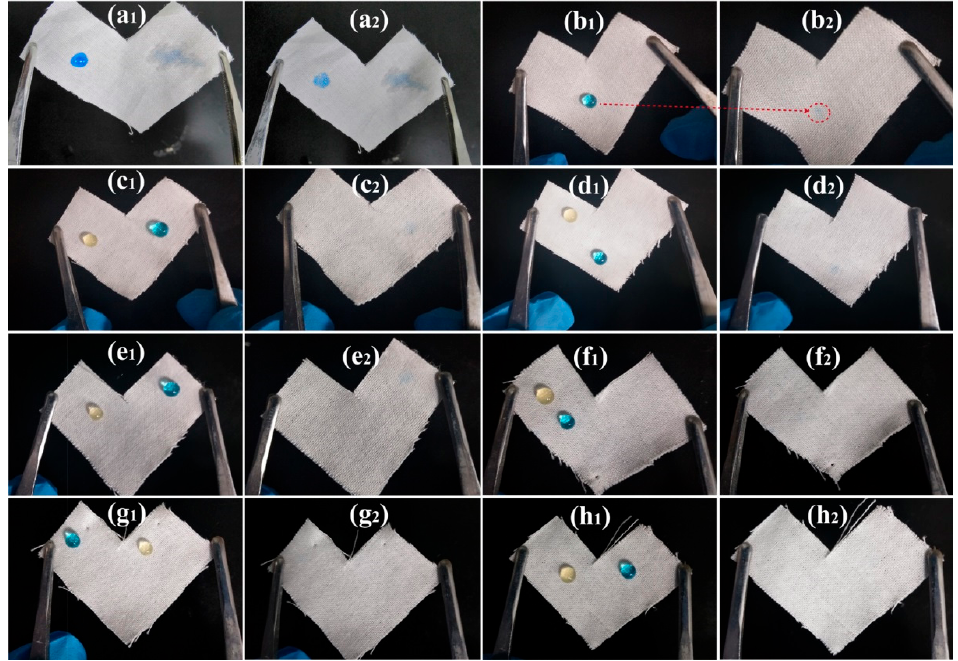
Figure 5. Stain resistance of cotton fabrics to orange juice and aqueous MB droplets: pristine cotton fabric ( a ), cotton fabrics modified by modifier solution with PMHS concentration of 0.05% ( b ), 0.10% ( c ), 0.50% ( d ), 1.00% ( e ), 5.00% ( f ), 10.00% ( g ), and 20.00% ( h ); x1 and x2 are photographs before and